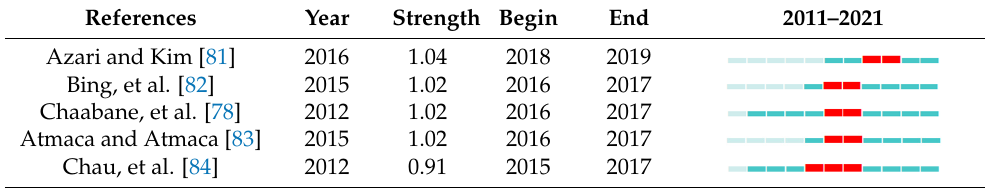
Table 9. Top 5 CLCSC papers ranked by burst detection.